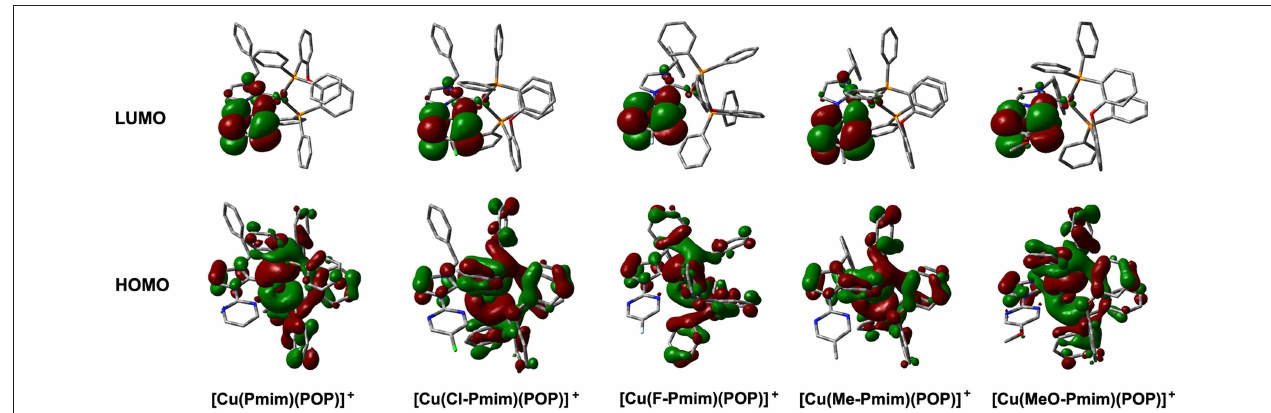
FIGURE 2 | Calculated molecular orbitals for the Cu(I)-NHC complexes. The “+” denotes a positive charge. Figure shows the DFT calculation results. The DFT calculations were performed without regard to the hexafluorophosphate anion in these complexes.